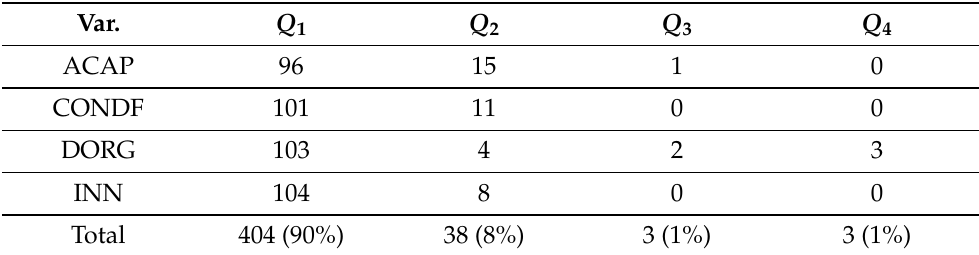
Table 11. Symmetry distribution of the STraDyCaF dataset.